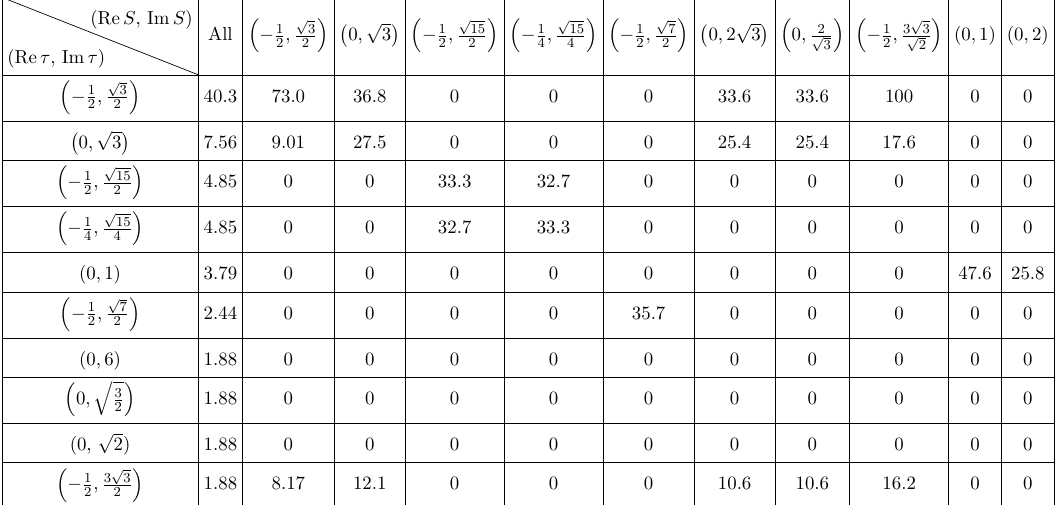
^ dz ^ dz in the 1 2 3